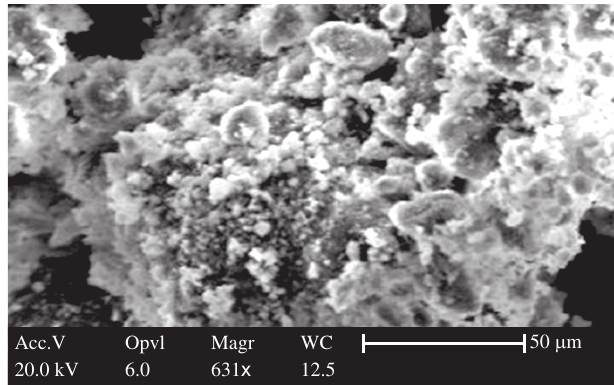
Table 2. Mineralogical composition of the zeolite and respective peaks.